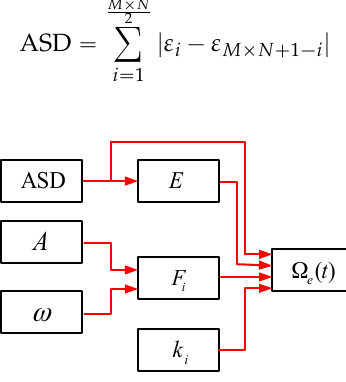
Figure 7. Factors that influence IFOG vibration error.